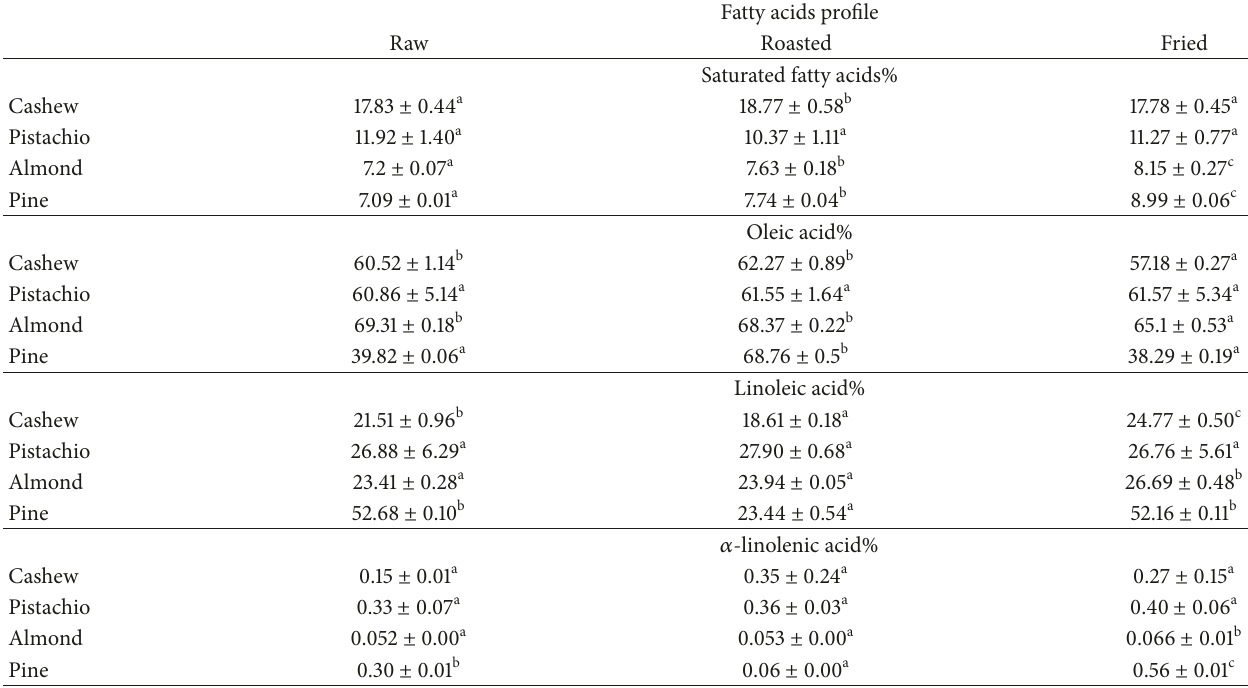
Table 2: Effect of roasting and frying on fatty acids profile as compared to raw nuts.